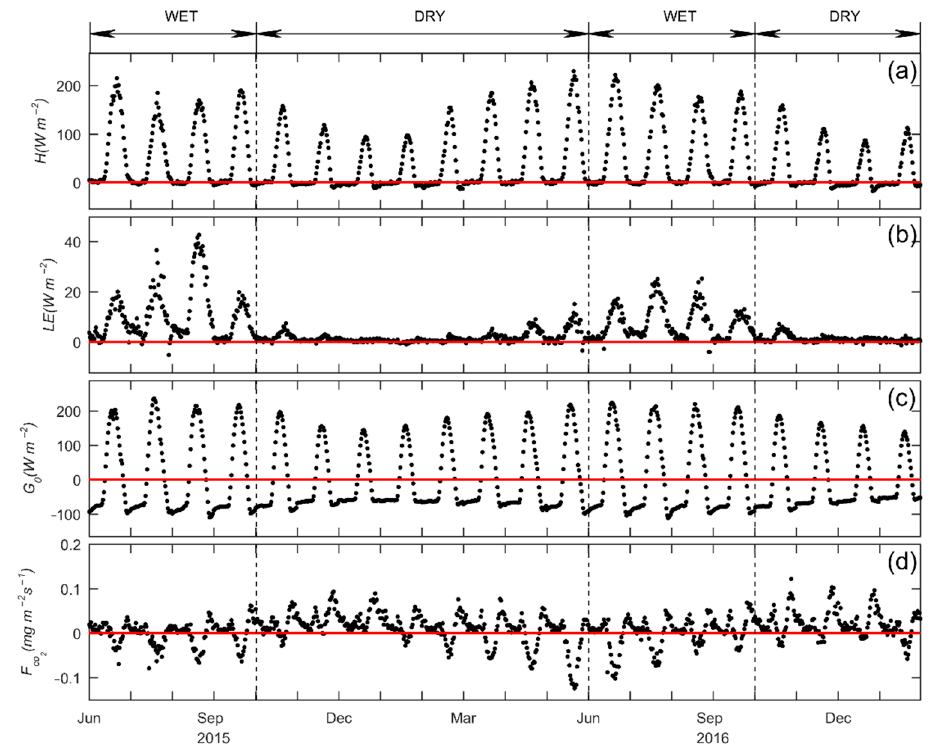
Figure 4. The monthly averaged diurnal variations of ( a ) sensible heat flux ( H in W m − 2 ), ( b ) latent heat flux ( LE in W m − 2 ), ( c ) soil heat flux ( G 0 in W m − 2 ) and ( d ) CO 2 flux ( F CO the period from June 2015 to January 2017 at the Shiquanhe site.